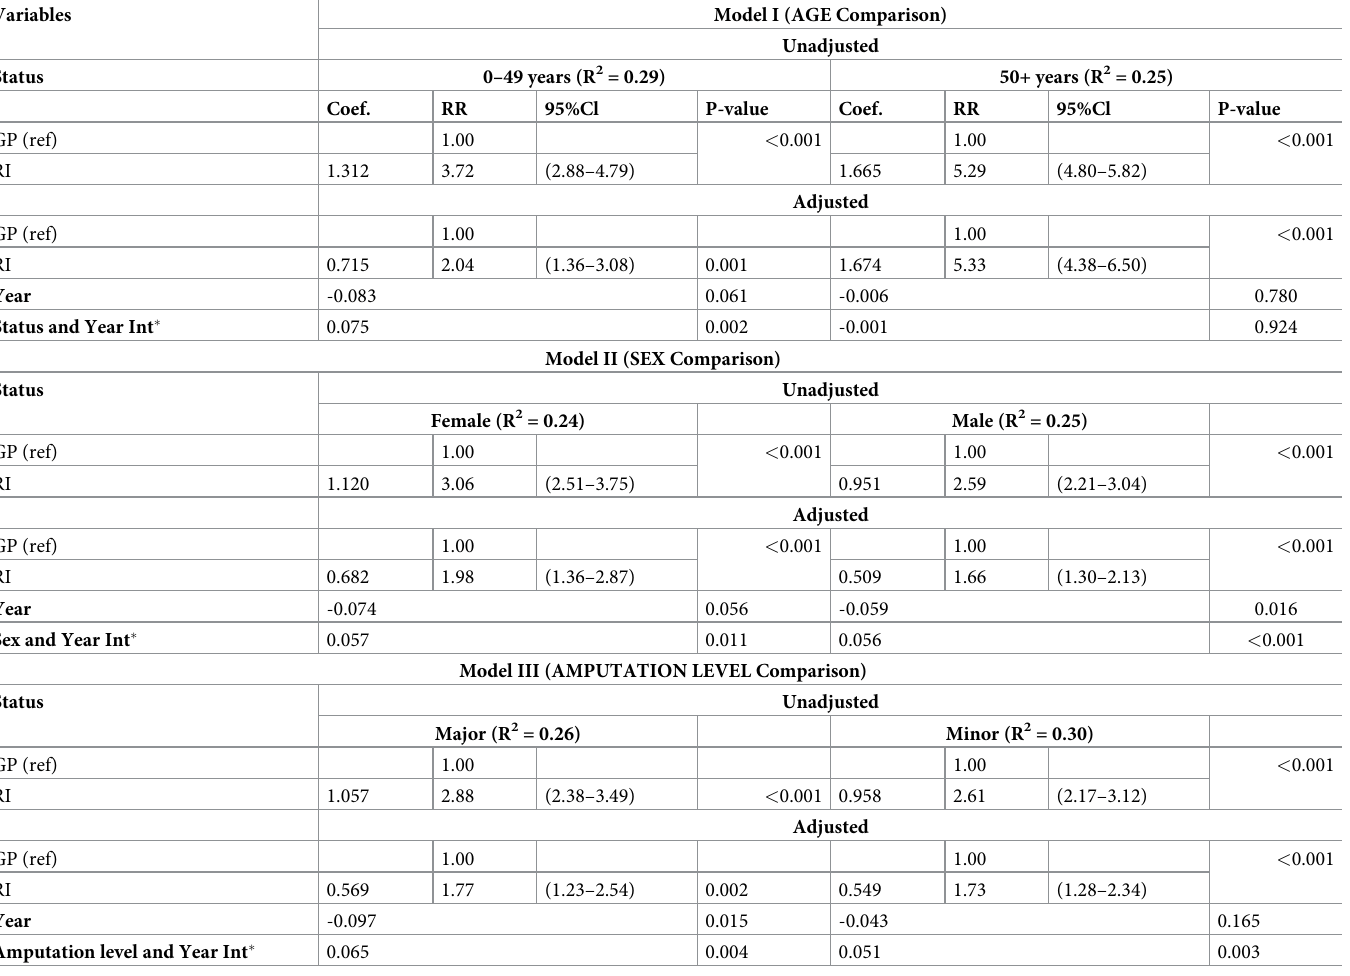
Table 3. Unadjusted and adjusted relative rates comparing amputation incidences among registered Indians and general populations.